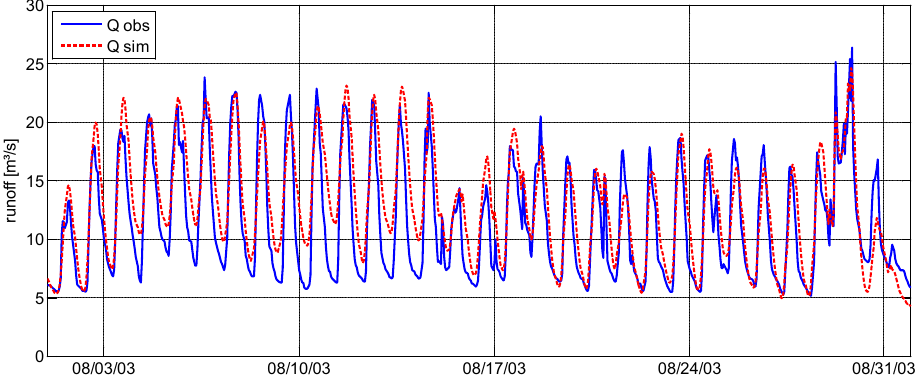
Fig. 3. Observed and simulated flow in hourly resolution for Gepatschalm catchment in August 2003 including the state of 29 August 2003 which represented the minimum snow cover in each of the analysed catchments.